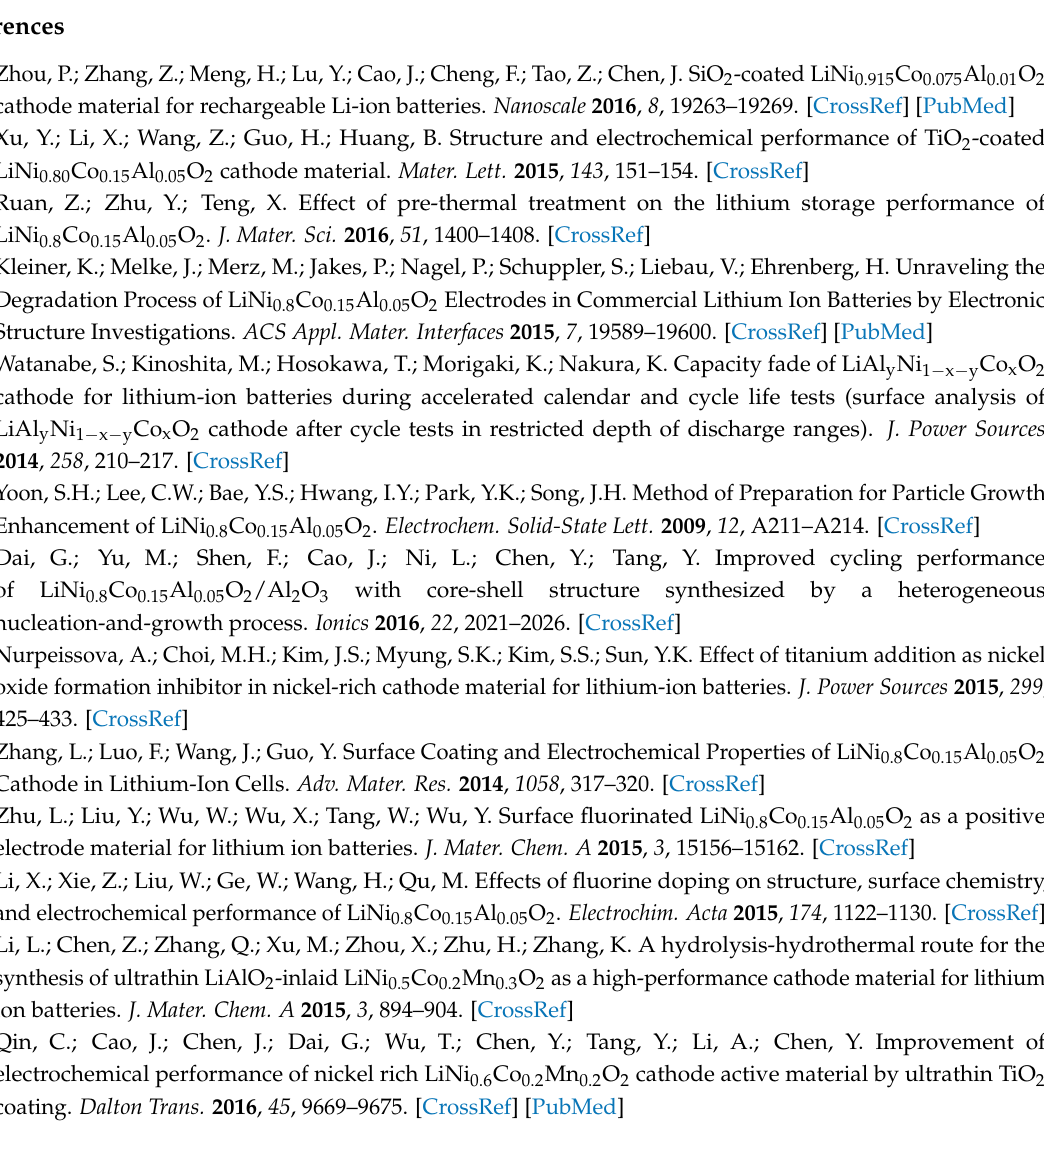
Figure S1: The mean and standard deviation diagrams of the three discharge of NCA series(NCA, NCA-0.25-400 ◦ C, NCA-0.25-500 ◦ C and NCA-0.25-600 ◦ C): blue, green and grey histograms correspond to discharge at 0.2 C, discharge at 1 C and discharge at 1 C after 110 cycles, respectively., Table S1: The each, mean and standard deviation of the three discharge of NCA, NCA-0.25-400 ◦ C, NCA-0.25-500 ◦ C and NCA-0.25-600 ◦ C,